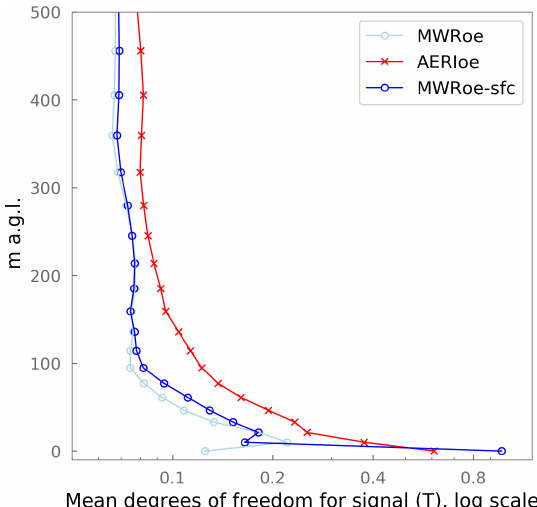
Figure 7. Mean degrees of freedom for signal across all temperature retrievals from the MWRoe (pale blue), the AERIoe (red), and the MWRoe constrained by the in-situ surface temperature measure- ment, MWRoe-sfc (dark blue).